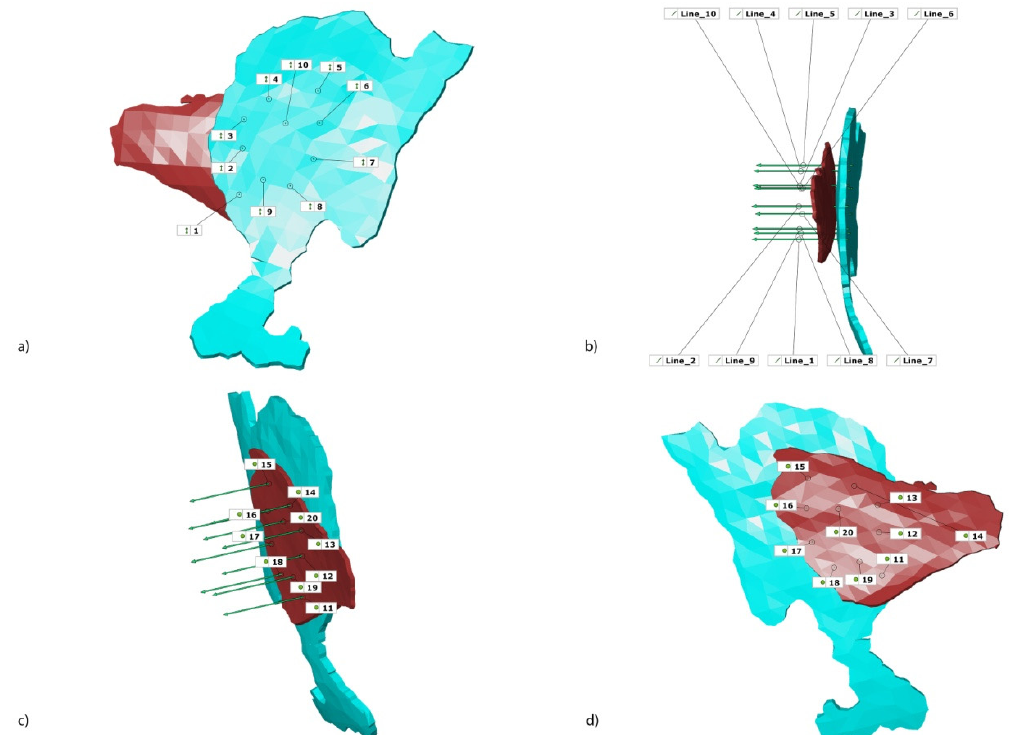
Figure 7. ( a ) Points randomly distributed at the inner surface of the interproximal enamel reduction mesh of the anterior tooth; ( b ) linen parallel projected to the tooth to the inner surface of the interproximal enamel reduction mesh of the posterior tooth; ( c ) points where the projected lines crossed the inner surface of the distal interproximal enamel reduction mesh of the posterior tooth; and ( d ) points at the inner surface of the distal interproximal enamel reduction mesh of the posterior tooth.